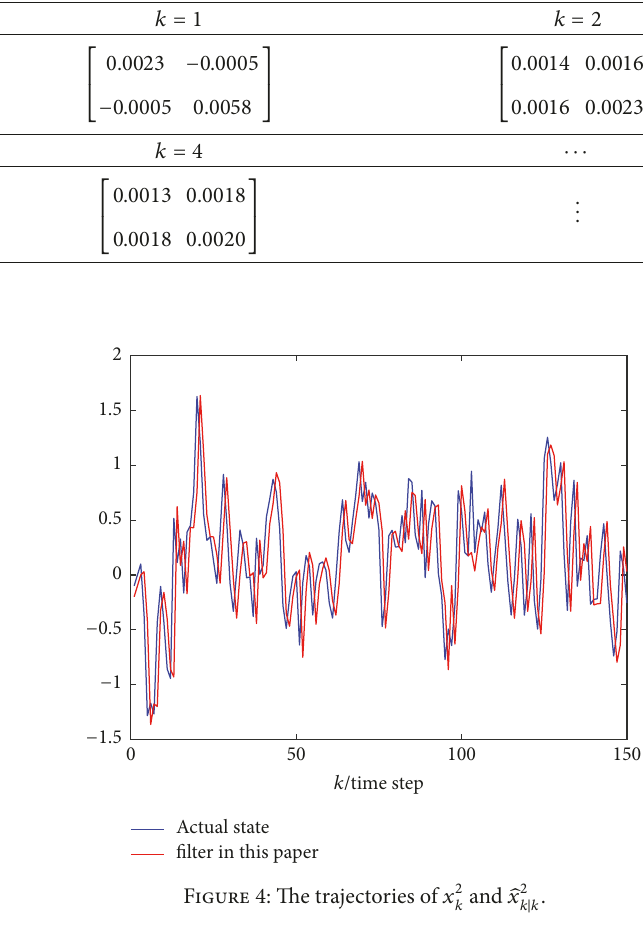
Table 2: The error covariance matrices 𝑃 𝑘+1 .